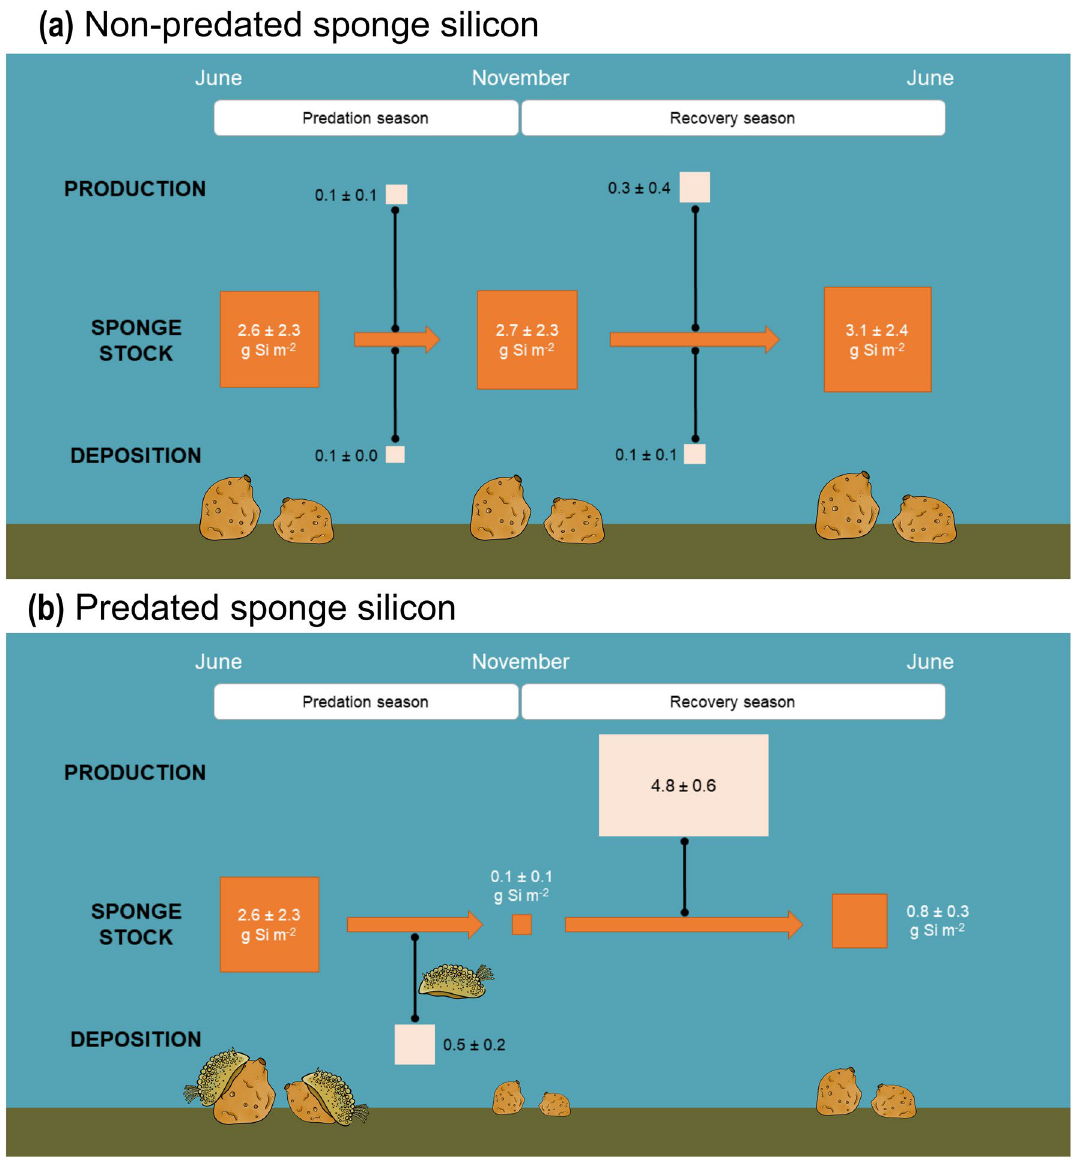
Figure 5. Scheme summarizing sponge silicon (Si) dynamics ( a ) as previously thought when predation is not considered and ( b ) integrating the predation effects measured in this study. The predation season of the nudibranch Doris verrucosa , which lasts from mid-June to mid-November, was determined from observations made during the survey of benthic fauna of the study area over the last decades (J. Grall, pers. comm.) and this study. Mean (± SD) sponge silicon stocks are indicated in g Si m −2 and stock-specific flux rates are dimensionless (g Si m -2 produced or deposited over the season considered : g Si m −2 of the initial sponge stock). The size of the boxes representing both stocks and stock-specific flux rates is proportional to their value. More details about the calculations are available in the main text and in Supplementary Information